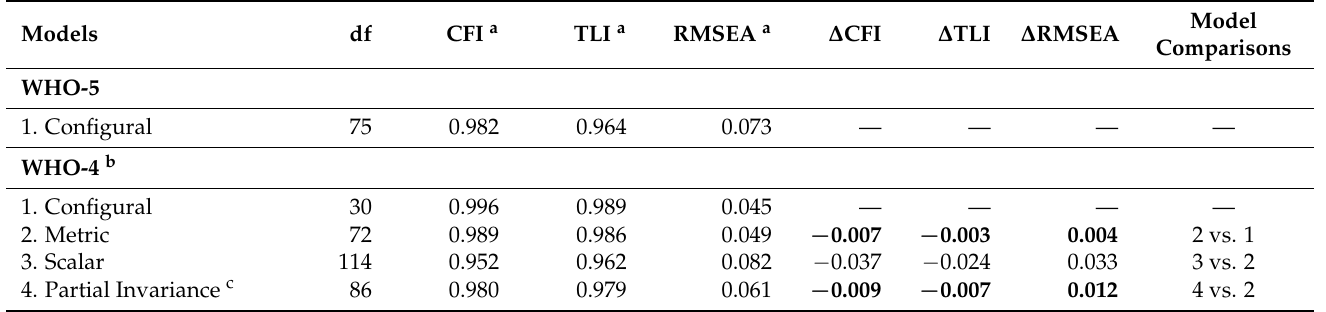
Table 3. Measurement invariance testing by country ( N = 74,071).